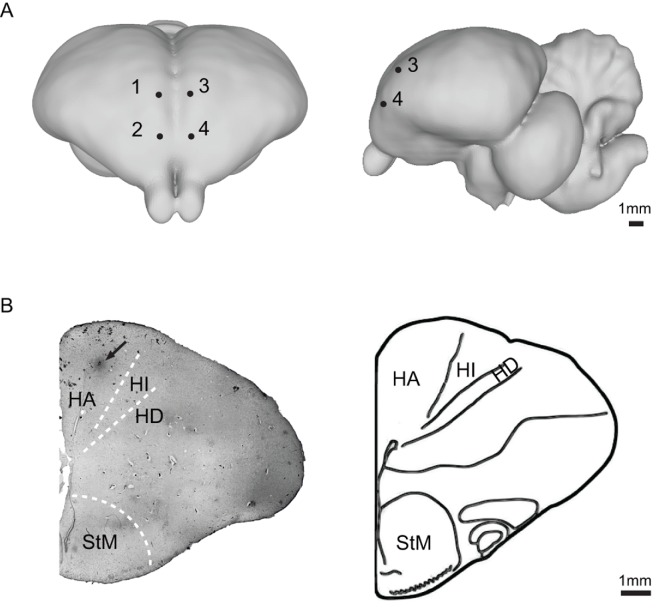
Location of injection sites of bilateral Wulst inactivation in the pigeon brain.(A) Frontal (left) and lateral view (right) of injection sites in the Wulst in both hemispheres (Karten and Hodos, 1967). The avian Wulst in the pallium is a multi-laminate structure that contains the HA (hyperpallium apicale), HI (hyperpallium intercalatum), and HD (hyperpallium densocellulare). Projections of the DLA mainly terminate in the HD and HI of the Wulst (Karten et al., 1973; Bagnoli and Burkhalter, 1983). The HA is the major area of the Wulst that sends projections forward to other visual and somatosensory/motor areas and back to the DLA in the brain (Karten et al., 1973; Reiner and Karten, 1983). Injection of 1 µl of muscimol (2%) can completely inactivate neuronal activities in a 2 mm diameter around the cannula tip for ~3 hr, and can significantly attenuate the neuronal activities in a 4 mm diameter (Partsalis et al., 1995; Arikan et al., 2002). On the basis of these studies, the Wulst was inactivated by injection of 1 µl of muscimol (2%) at four different coordinates: (1: A10, L1.5, H1.5) and (2: A12, L1.5, H1.5) in the right hemisphere, and (3: A10, L1.5, H1.5) and (4: A12, L1.5, H1.5) in the left hemisphere. Muscimol and direct-blue have different spread extents in the brain. The locations of the muscimol injection sites were confirmed by injecting 0.2 µl of direct-blue 15 (2% direct-blue 15 in 0.5 M sodium acetate solution). (B) The location of one injection site (arrow) in the Wulst at A12.00 (left) and the corresponding schematic drawing of the brain section (right) are shown (Karten and Hodos, 1967). Abbreviations: StM, striatum mediale.